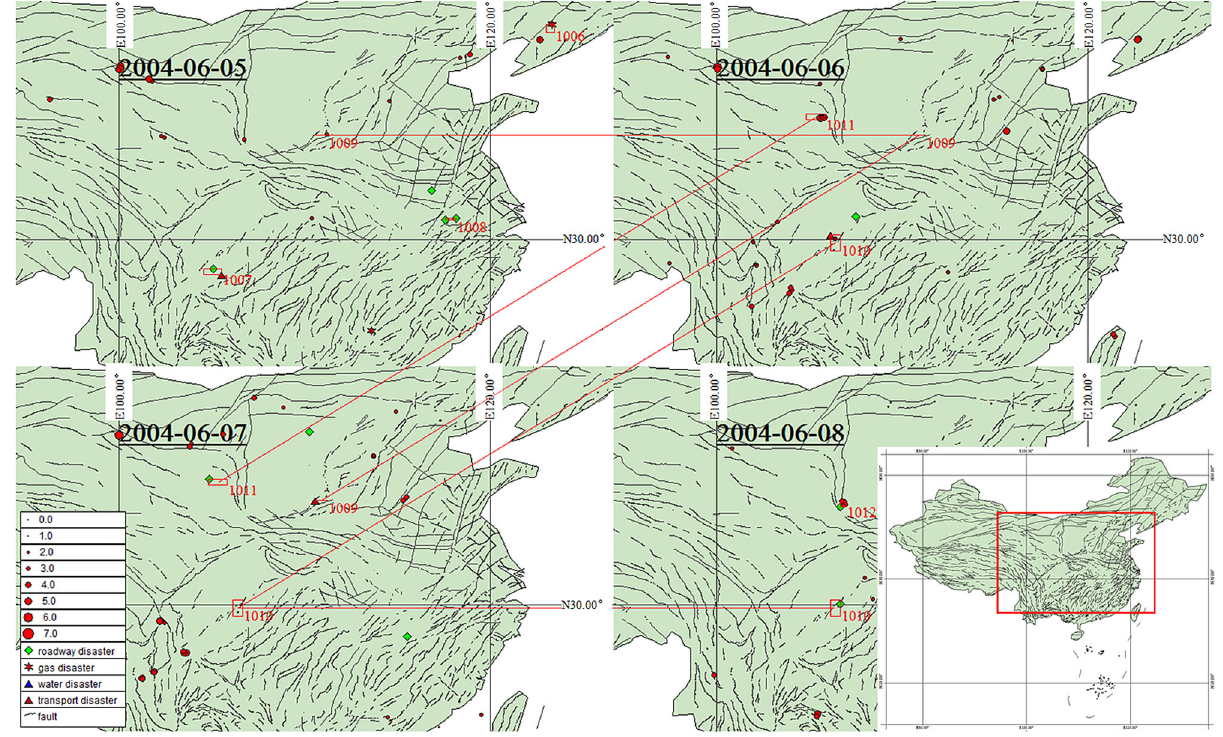
Fig. 6 Coal mine disasters and microearthquakes occurring over continental China during the period from 5 to 8 June